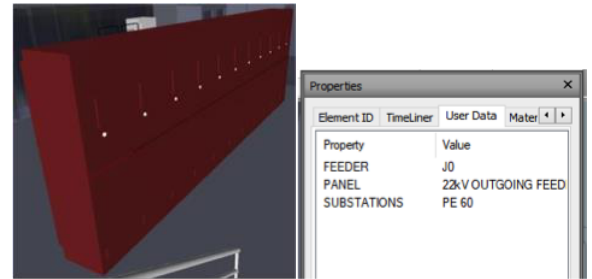
Figure 9: The 22kV Feeder Panel and its Attributes